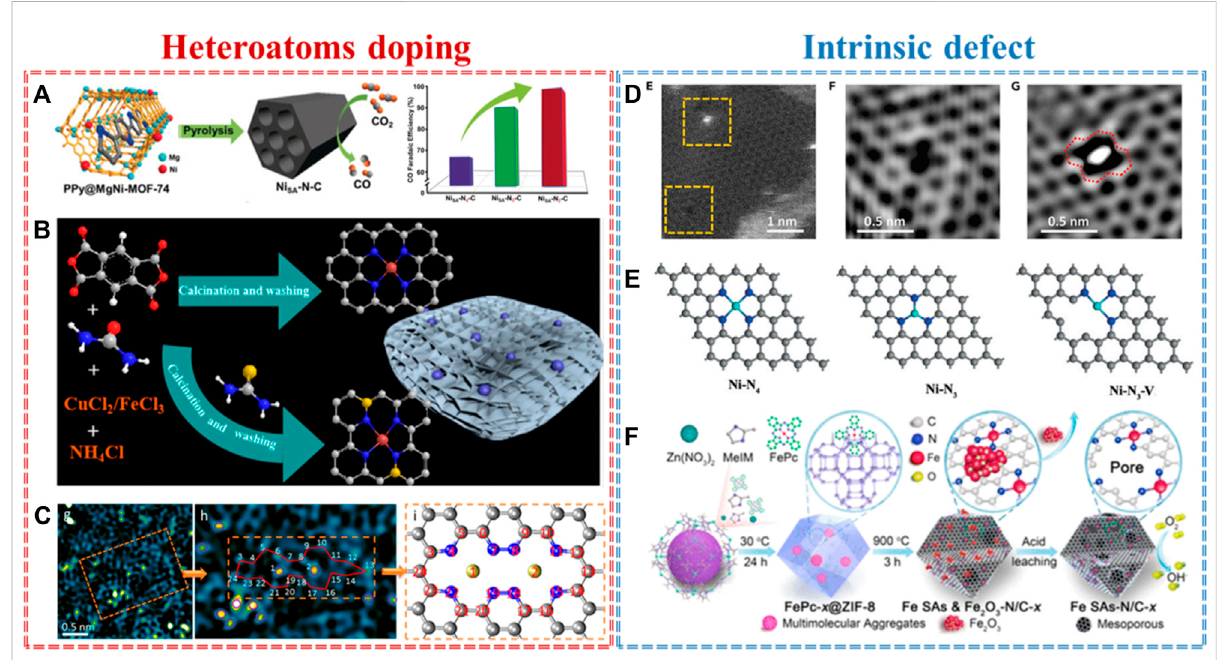
FIGURE 1 Heteroatom doping: (A) single atomic Ni – Nx – C (x = 2, 3, and 4) for CO 2 RR (Gong et al., 2020), (B) Cu/Fe – N(S)C SACs with defect-rich carbon forelectrochemicaldenitri fi cation(Lietal.,2021), (C) atomicCo-PtsupportedonNdopedcarbonforORR(Zhangetal.,2018a).Intrinsicdefects: (D) graphene defects trap atomic Ni species for HER and OER (Zhang et al., 2018b), (E) vacancy-defect Ni SACs for CO 2 RR (Rong et al., 2020), and (F) edge-hosted